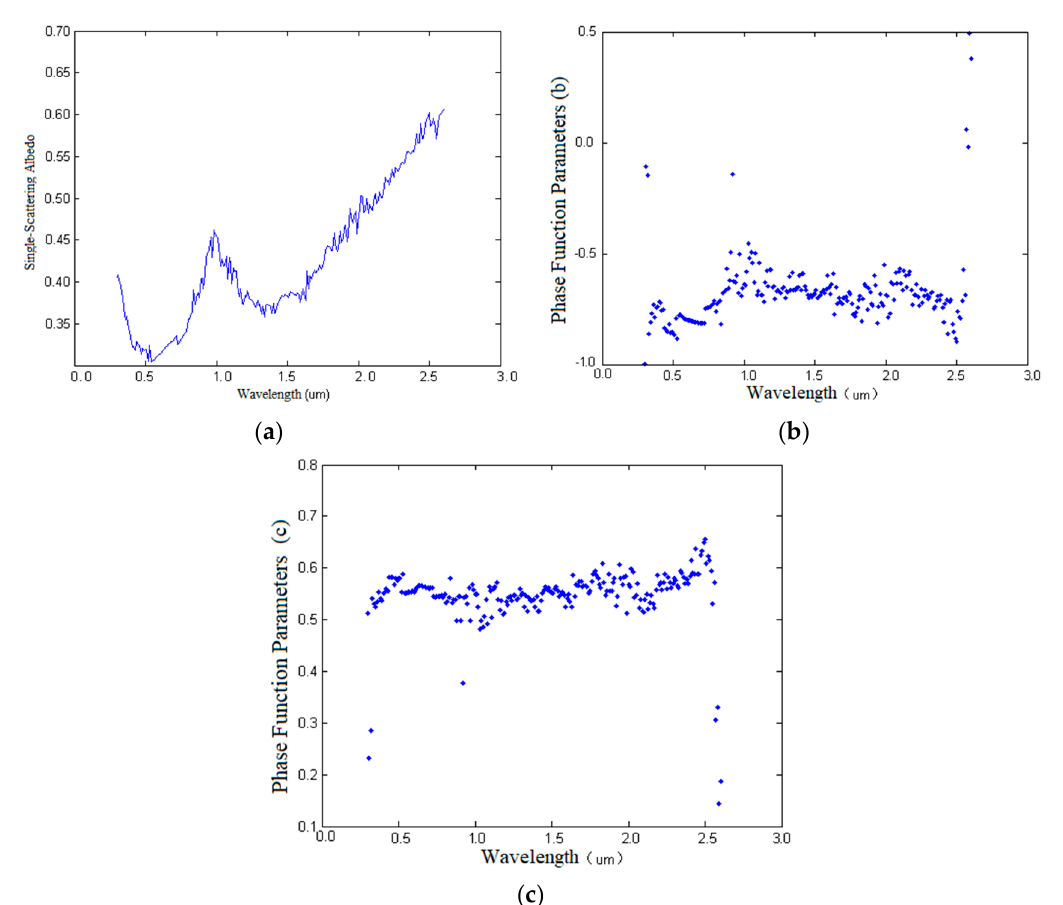
Figure 17. Photometric parameters of ilmenite: ( a ) SSA (w), ( b ) Legendre polynomial coefficients of the phase function b, and ( c ) Legendre polynomial coefficients of the phase function c of ilmenite.